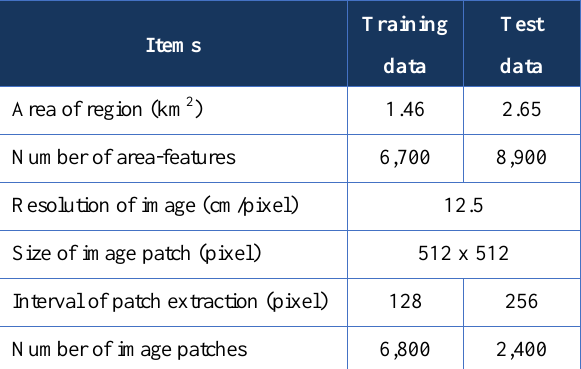
Figure 3. Partial area of dataset (yellow points indicate the ground truth of label placement by manual operation)